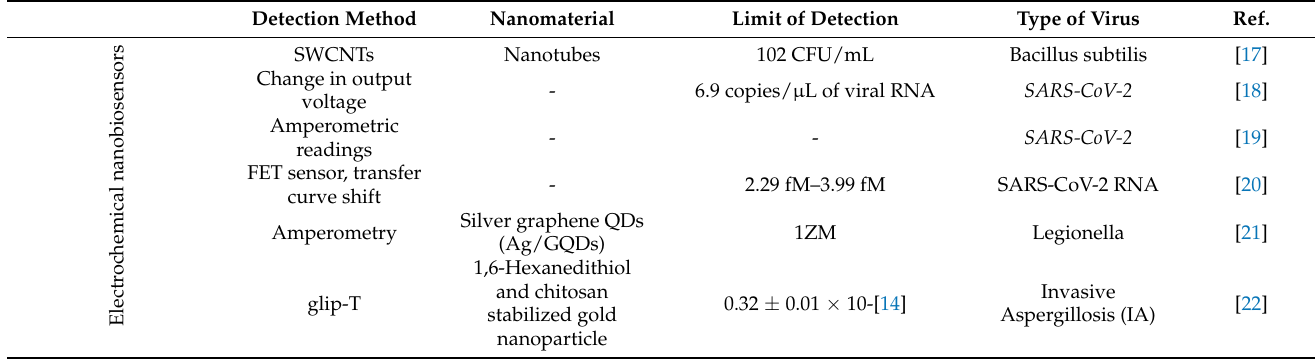
Table 1. Overview of electrochemical and optical nanobiosensors in viral detection. Detection